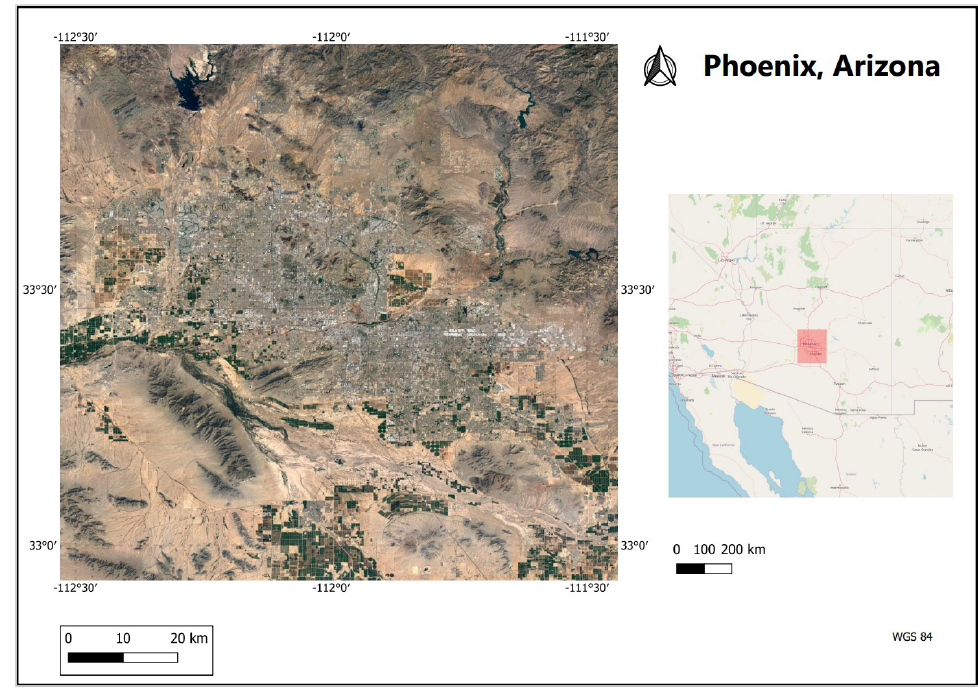
Figure 4. The study area covering the city of Phoenix, the capital of Arizona, United